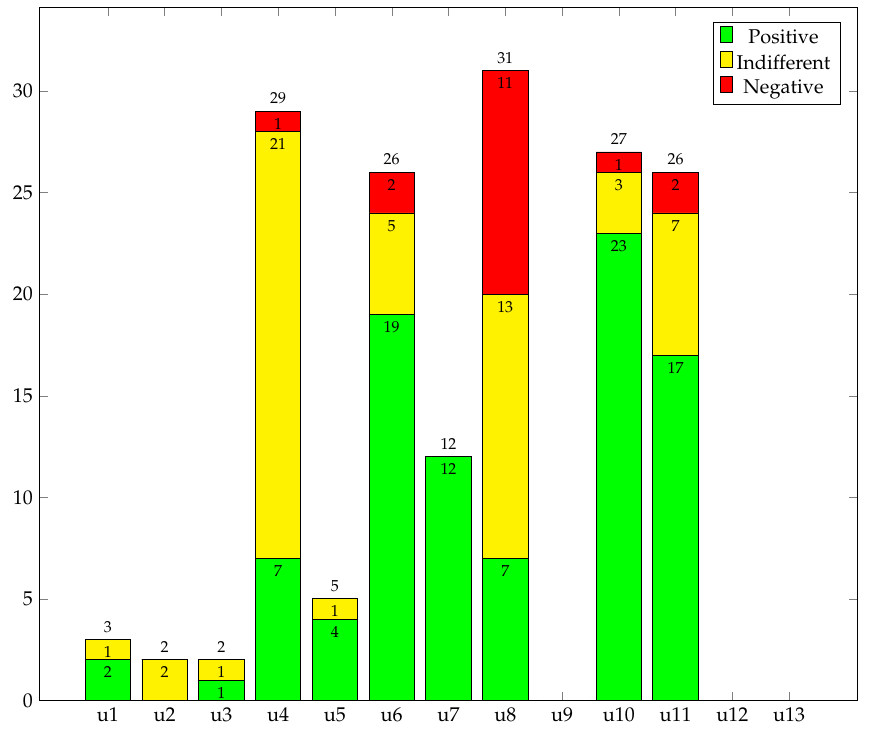
Figure 22. Users’ feedback on exercises